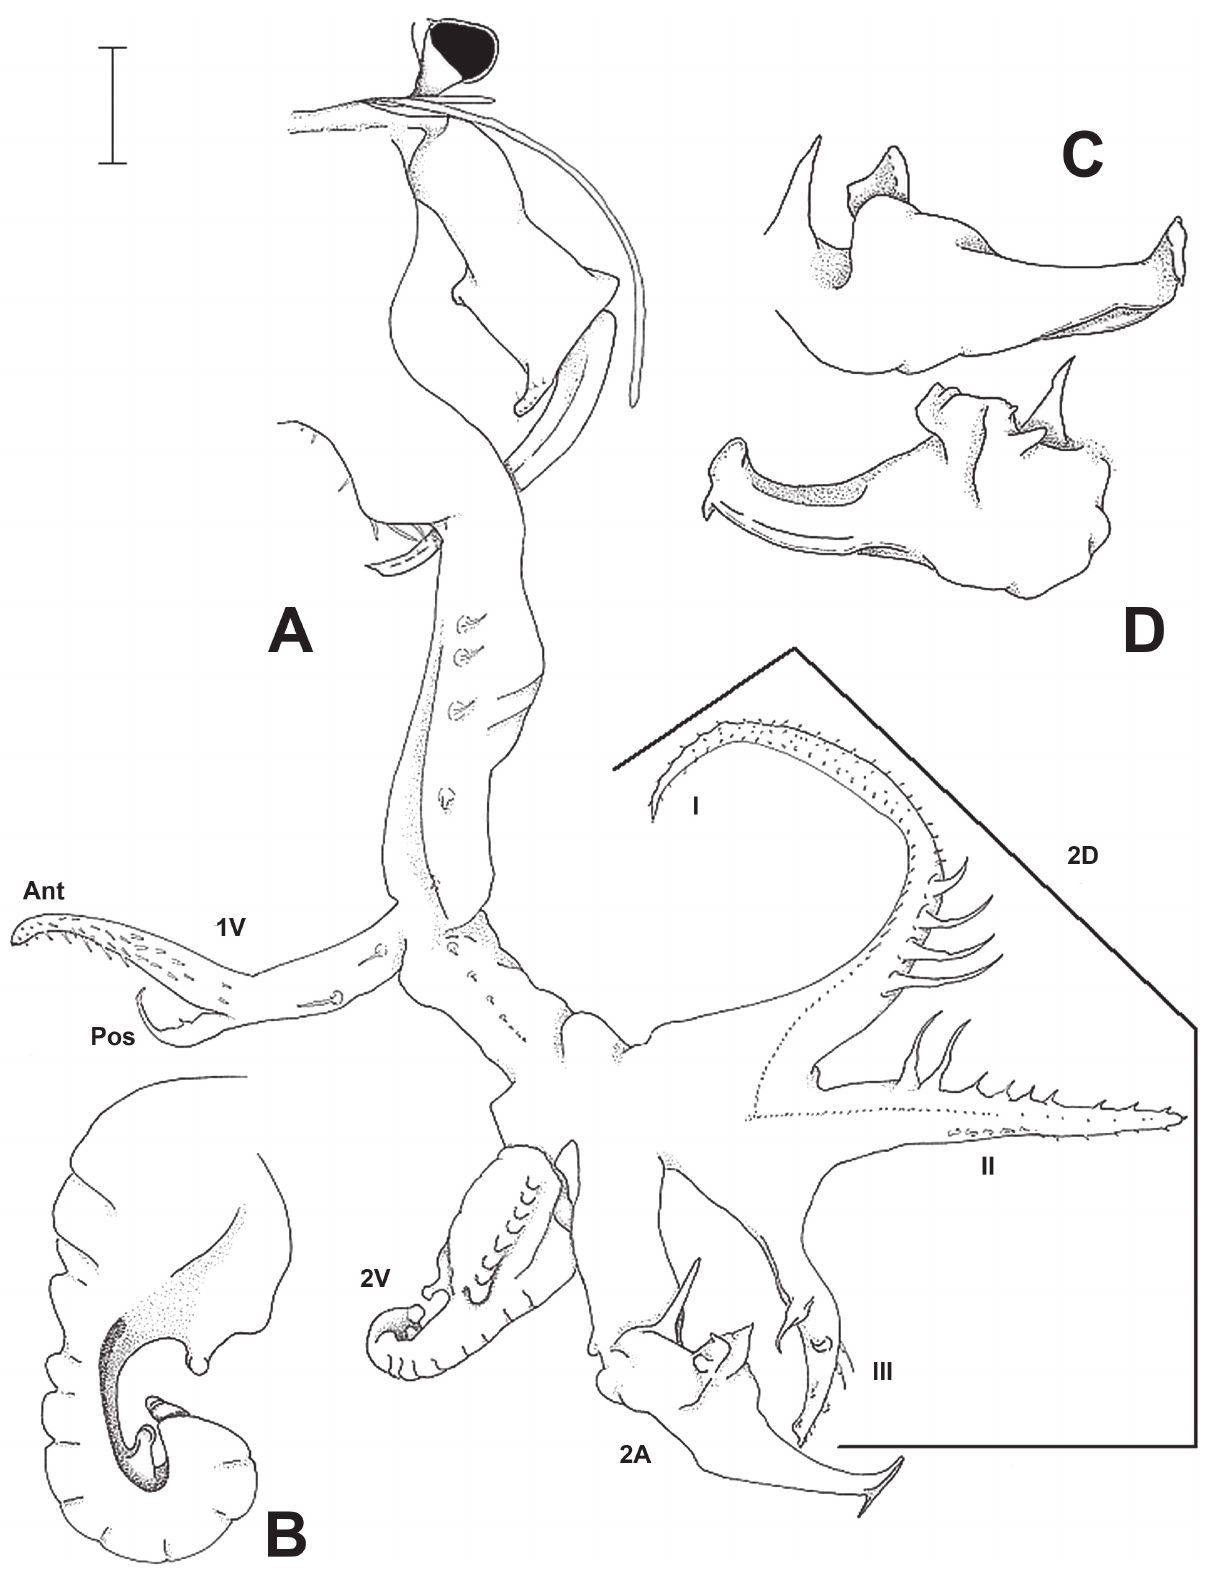
Figure 1. Dendrocephalus riograndensis n. sp., male holotype (MCP 3144): A) left side of head anterior view, with left half of cephalic appendage, medial view. Terminology follows Pereira (1983): 1V = first ventral branch (with anterior (Ant) and posterior (Pos) sub-branches); 2V = second ventral branch; 2D = dorsal branch (with sub –branches I, II and III); 2A = apical branch. B) 2V detail, lateral view. C) 2A detail, medioposterior view. D) 2A detail, lateral view. Scale bar: A, 2 mm; B–D, 1